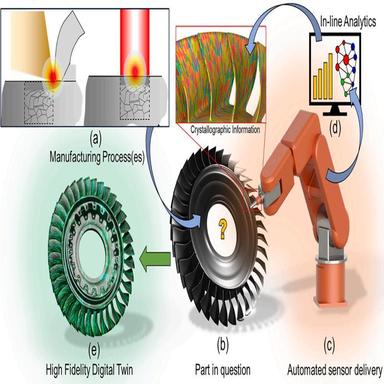
A vision for metallurgical characterisation during production in additive manufacturing and allied high value processes. The 'integrity problem' persists as a blocker for the adoption of additive manufacturing in many sectors. The incorporation of non-invasive approaches for metals characterisation requires a rethink in industrial practice. The ability to move away from destructive and remote analysis to the direct evaluation of crystallography represents a significant prize for industrial practitioners. Th